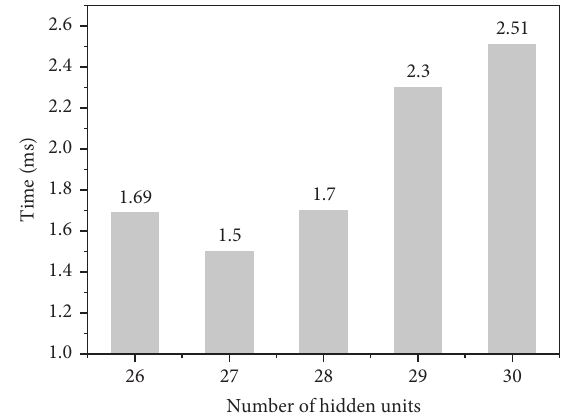
Figure 7: Test computation time based on the